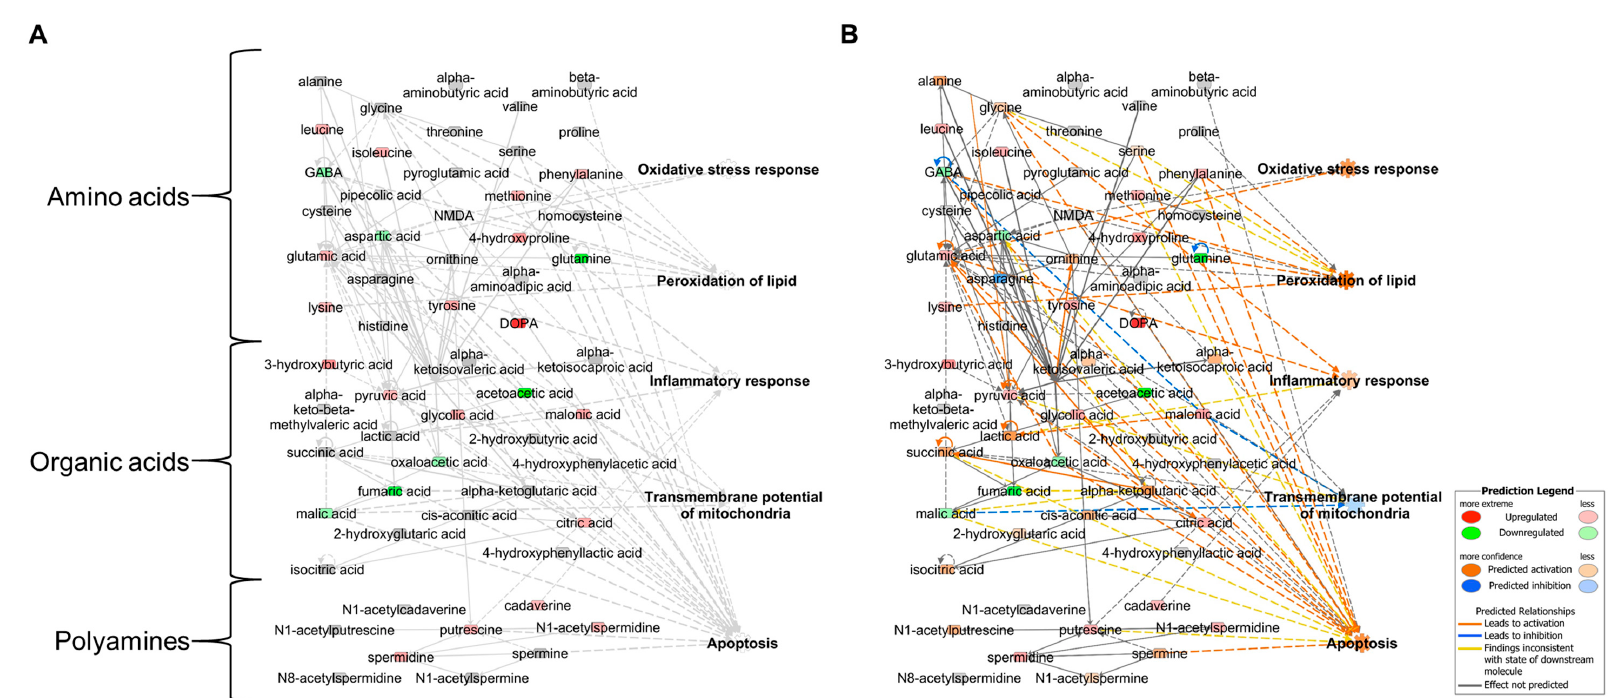
Figure 3. Functional analysis of metabolomic network of MCAo rat brain tissue using IPA. Metabolomic network ( A ) and metabolomic network with prediction ( B ). Fold change ± 1.2 was used as cut-off value. Red and green areas indicate up- and downregulated metabolites, respectively. Orange and blue areas indicate prediction as activation and inhibition, respectively. Prediction Legends are originated from Ingenuity Systems (http://www.ingenuity.com).